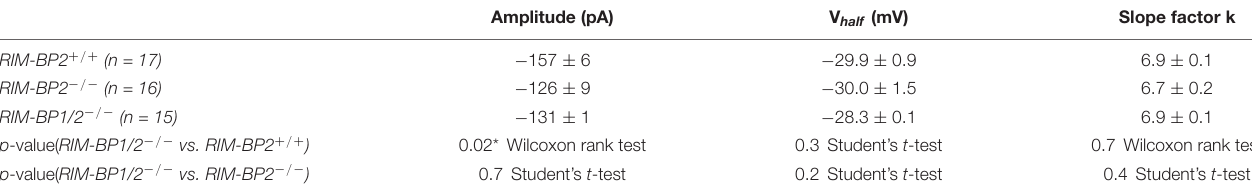
TABLE 2 | Summary of Ca 2 + -current (I Ca ) data from perforated patch-clamp recordings.